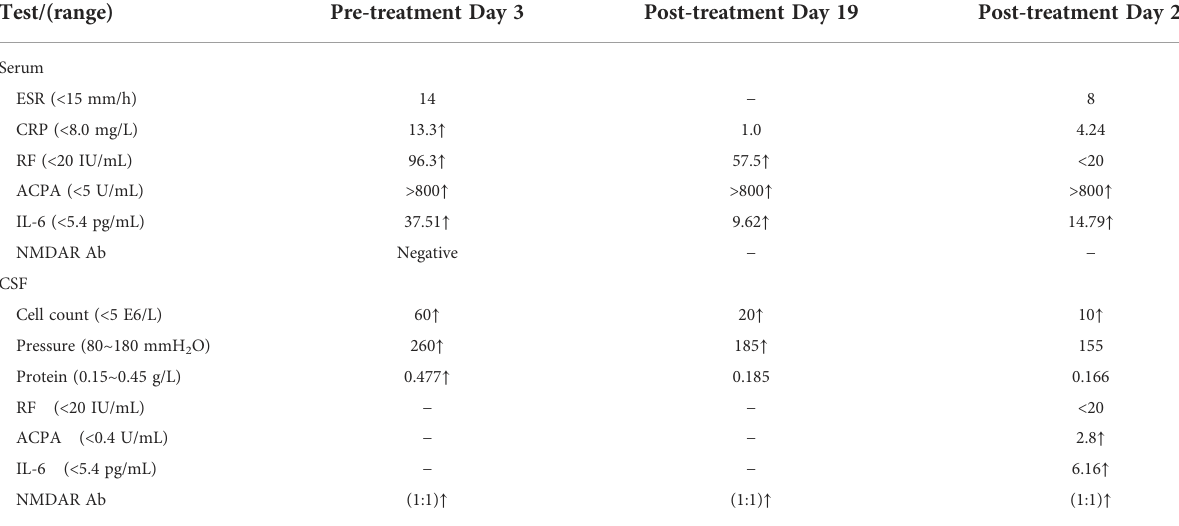
TABLE 1 Serum and CSF markers before and after